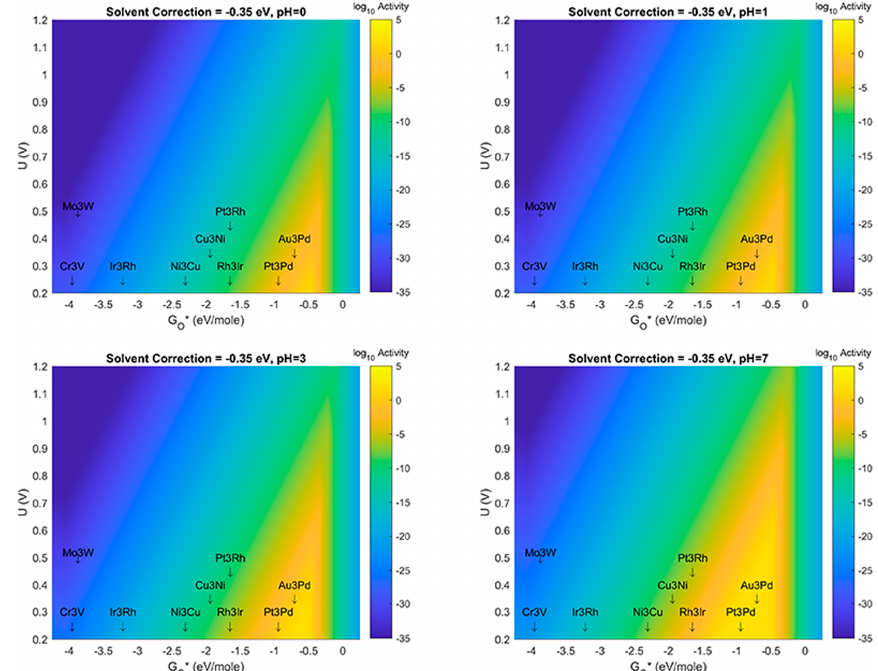
Figure 7. Volcano Plot analysis for ORR activity at solvent correction value of − 0.35 eV. Top left (pH = 0), Top right (pH = 1), Bottom left (pH = 3), Bottom Right (pH = 7). Blue denotes lowest activity, yellow denotes highest activity. All plots use same color-axis scale hence some saturation at maximum activity and minimum activity. Activity given in log10 scale to show more detail in plot.